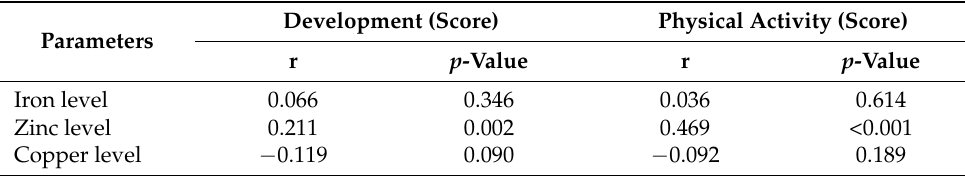
Table 7. Correlation of trace element levels with development/physical activity scores.